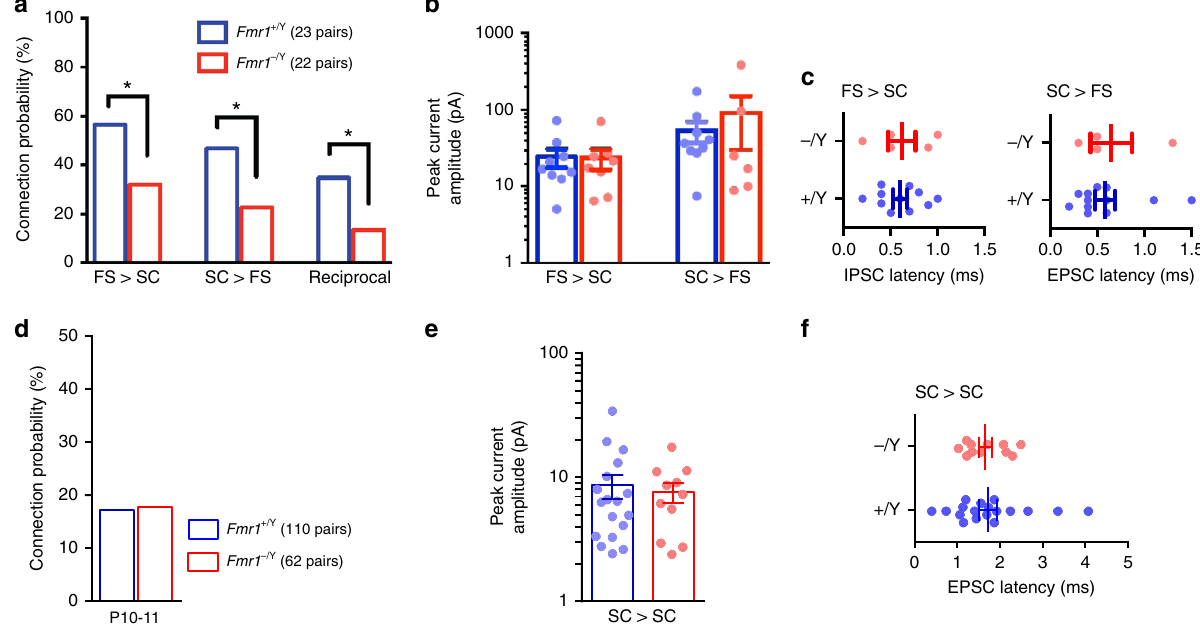
Fig. 2 Reduced FS IN – SC connectivity in Fmr1-KO , but no change in connection properties. a Monosynaptic connection probability between pairs of FS and SCs tested with paired whole-cell recording. Asterisks: p < 0.05, Chi-squared test. b , c Connection strengths ( b ), peak evoked monosynaptic current amplitude and current onset latencies ( c ) for connected pairs shown in ( a ). No differences in connection strength between genotype were observed for either connection direction ( p > 0.05, Mann – Whitney, N ’ s as in ( a )). d Monosynaptic connection probability between pairs of SCs located within the same barrel for recordings in slices taken from P10 – 11 mice of each genotype. No change in connection probability was observed ( p > 0.05, Chi-squared test). Not shown: Signi fi cant reduction in SC – SC connectivity for Fmr1 − /Y at P12 – 15 (37/110, 8/54 tested pairs connected for Fmr1 + /Y and Fmr1 − /Y , respectively, χ 2 (1) = 7.78, p < 0.01). e , f No change in synaptic strengths ( e ) or peak monosynaptic EPSC amplitude ( f ) between the connected SC pairs from P10 – 11 Fmr1 + /Y and Fmr1 − /Y littermate mice shown in ( d ) ( p > 0.05, Mann – Whitney, N ’ s as in ( a